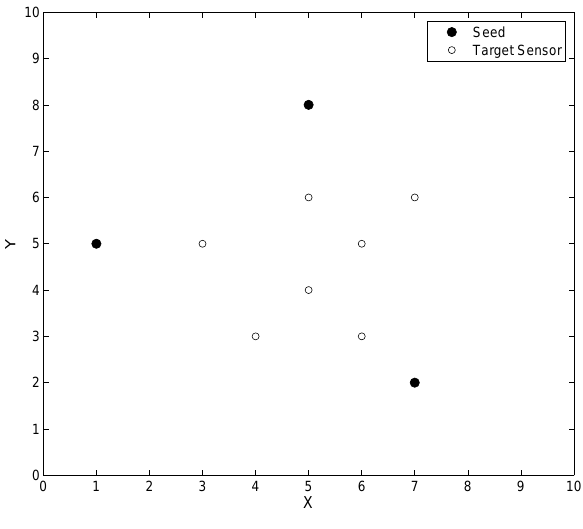
Figure 13. The locations of seeds and unknown target sensors.